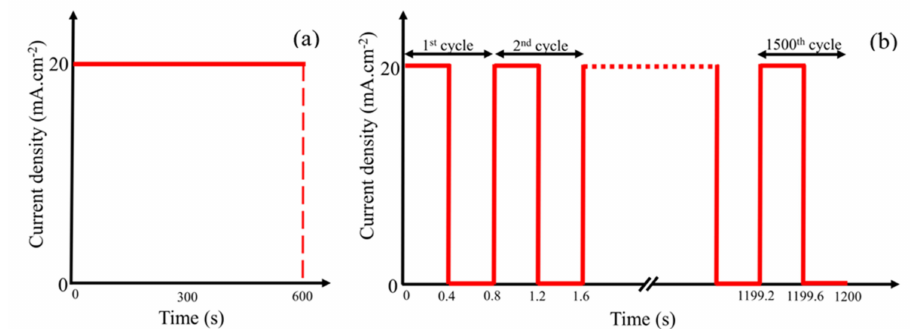
Figure 1. Current density-time curves of the electrodeposition procedure on plain carbon steel using optimum condition of leaching measurements as an electrolyte, ( a ) current control mode, and ( b ) pulsed current